Question: Provide a publication-style caption for this figure.
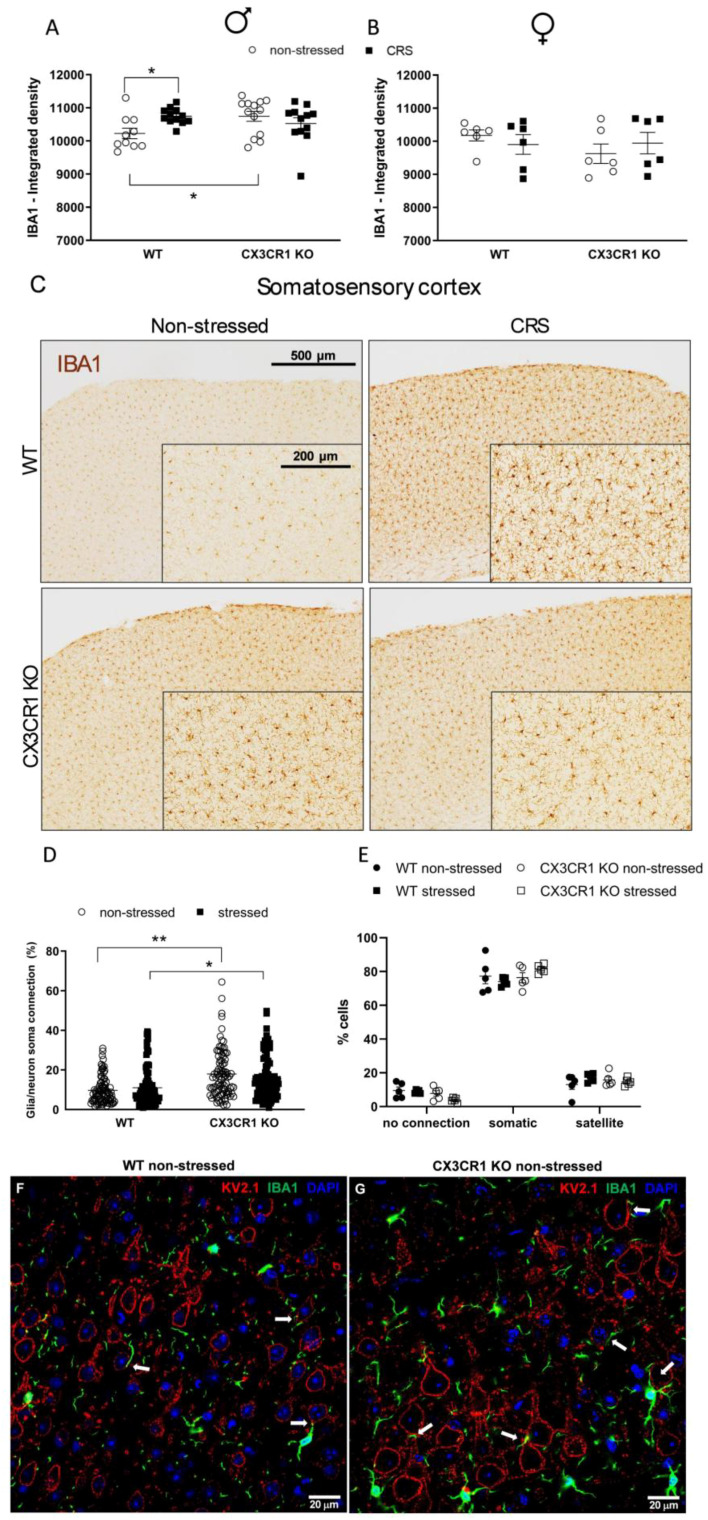
Answer: Effects of chronic restraint stress (CRS) on ionized calcium binding adapter protein 1 (IBA1) integrated density in the somatosensory cortex (S1HL) of male [ (A) , n=11-13/group] and female [ (B) , n=6/group] wild-type (WT) and CX3CR1 knock-out (KO) mice. Data are presented as the mean ± SEM, animals with individual plots. Two-way analysis of variance (ANOVA), followed by Tukey’s tests; *p<0.05. Representative images show the IBA1+ microglia cells in male animals’ S1HL (C) . #Effects of CRS on contact prevalence between microglia and neurons in WT and KO mice [ (D) , n=18/neurons from 5 mice] and percentage of non-connecting, microglia with somatic contacts and satellite microglia cells [(E), n=5]. Data are presented as the mean ± SEM, animals with individual plots. Two-way analysis of variance (ANOVA), followed by Sidak’s tests; *p<0.01, **p<0.0001 vs. indicated groups. Representative images of neuron-glia connections in control WT and CX3CR1 KO male animal somatosensory cortex. White arrows indicate microglial processes (green) contacting Kv2.1 clusters (red) on neuronal somas in perfusion-fixed brain tissue samples of the somatosensory cortex in WT (F) and CX3CR1 KO (G) animals.